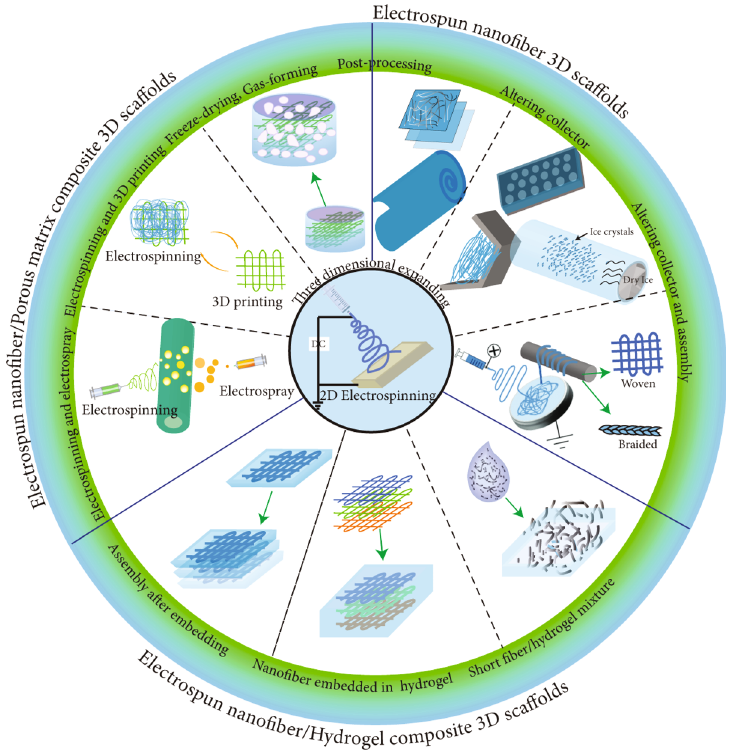
Figure 2: The summary of representative design approaches of 3D